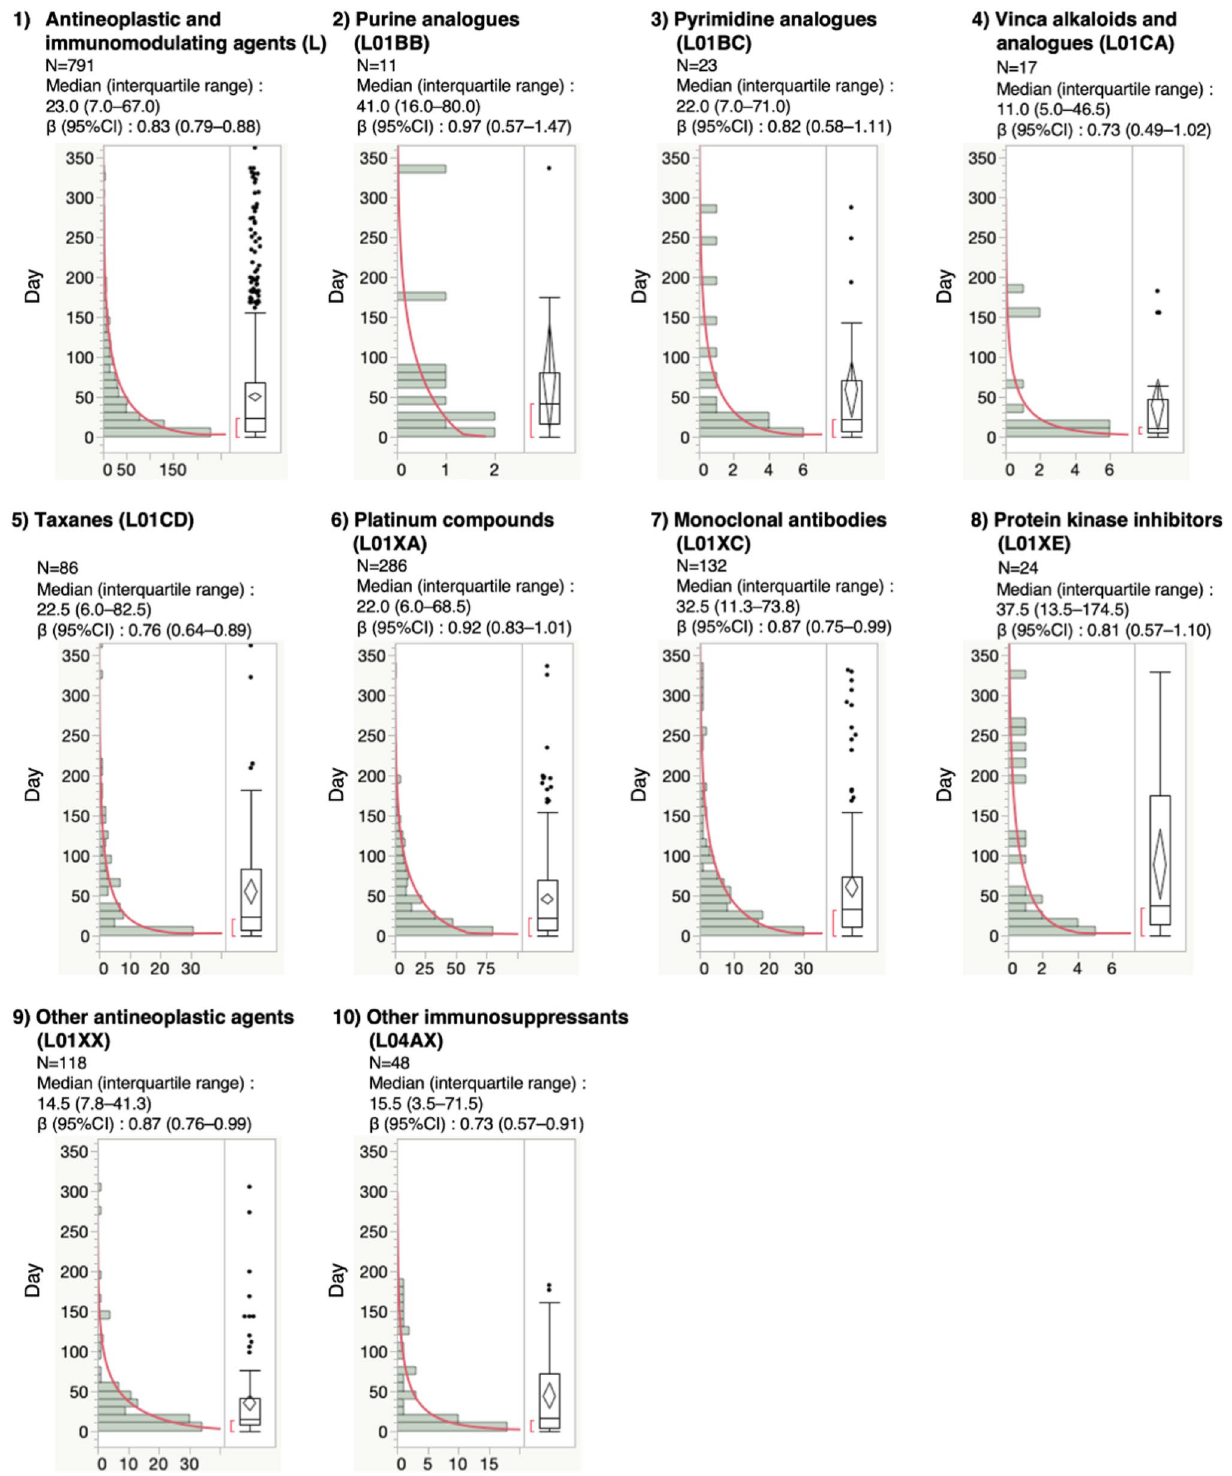
Figure 2. Histogram and Weibull shape parameter of chemotherapy-induced peripheral neuropathy for each drug in the ATC classification. Right panel shows box plots, which represent the median (the horizontal line within the box). The ends of the box represent the 25th and 75th quantiles, also expressed as the 1st and 3rd quartile, respectively. The confidence diamond contains the mean and the upper and lower 95% CIs of the mean. The whiskers extend to the outermost data point that falls within the distances of 1.5 times the length of the inner quartiles. The bracket outside the box indicates the shortest half, which is the densest 50% of the